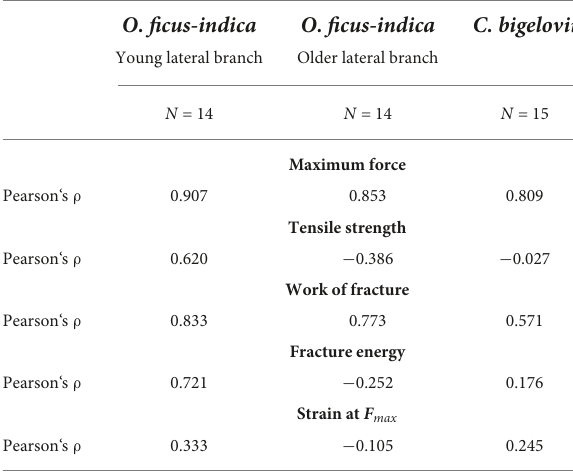
Correlation with apical branch